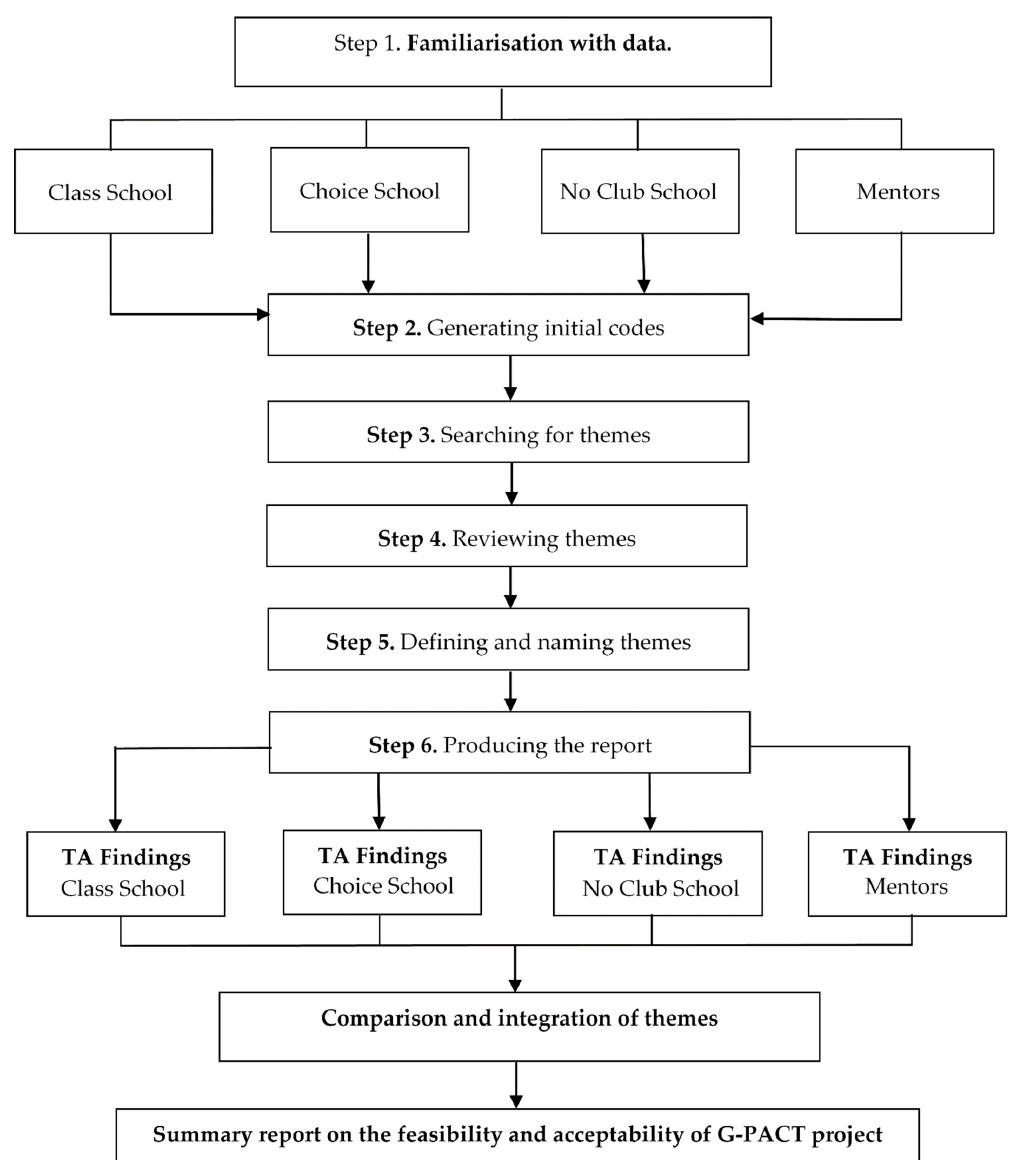
Figure 1. The application of step-by-step thematic analysis (TA) [34].